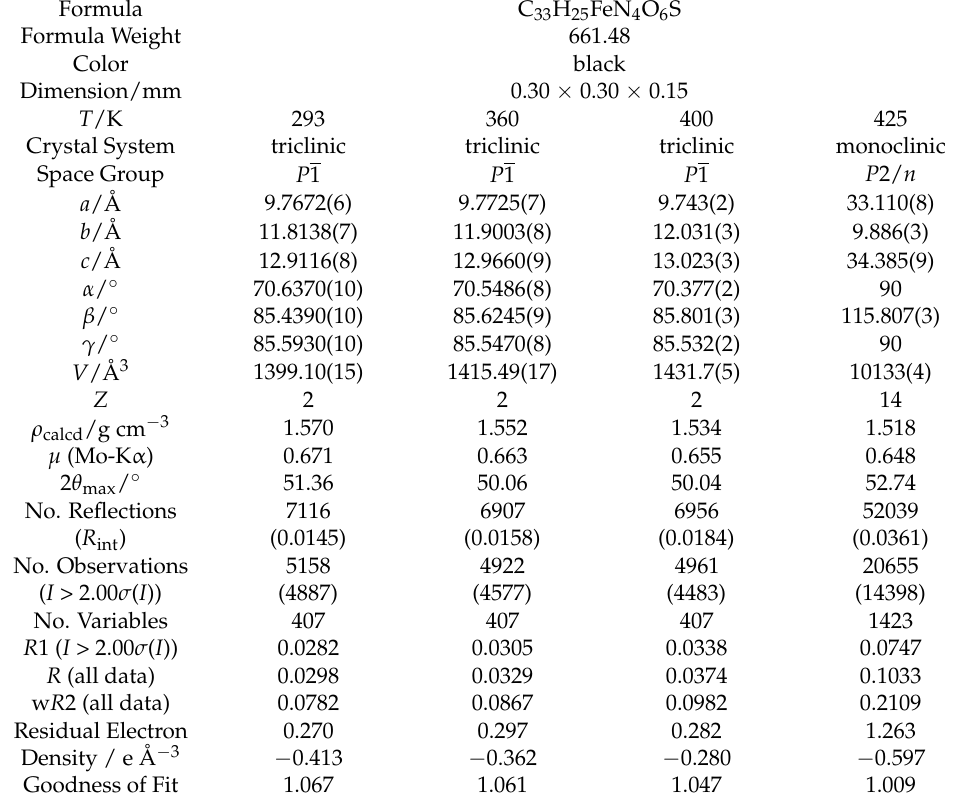
Table 3. Crystallographic data for 1